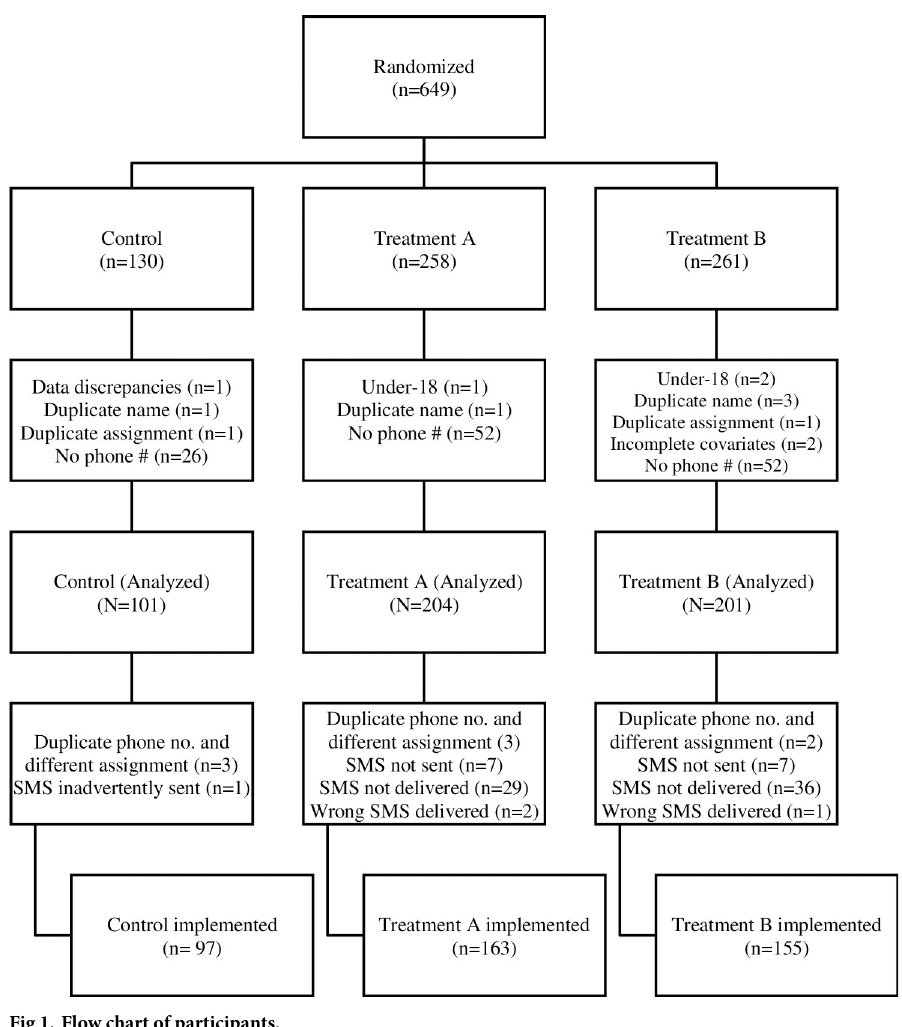
Fig 1. Flow chart of